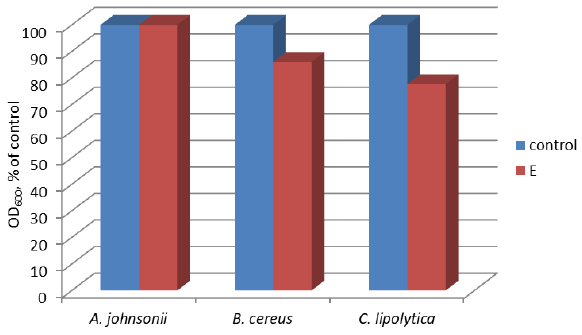
Figure 7: Effect of visible light on planktonic cultures of P. aeruginosa in presence of compound E.